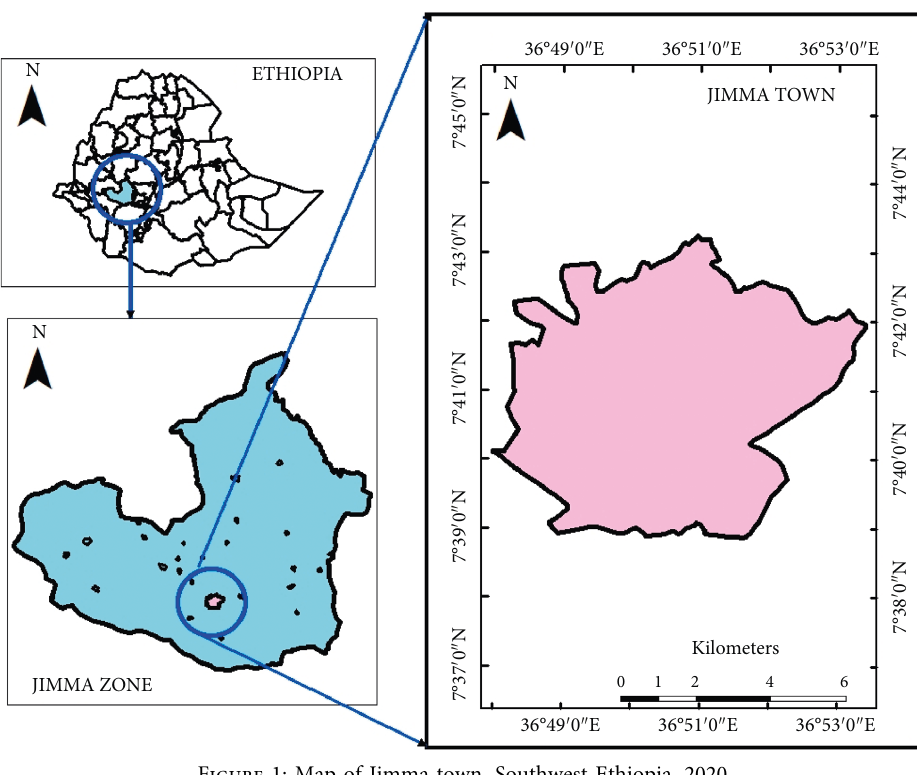
Figure 1: Map of Jimma town, Southwest Ethiopia, 2020.